Question: Write a single sentence explaining what this figure depicts.
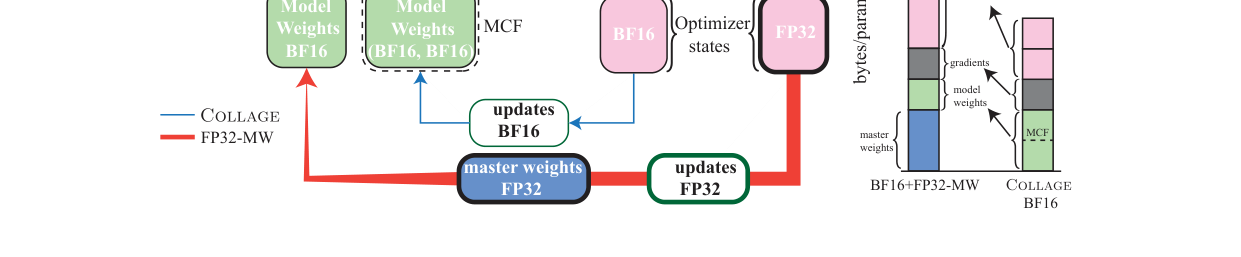
Answer: Left: COLLAGE uses a strict low-precision floating-point (such as BF16) optimization loop without ever needing to upcast to FP32 like in the mixed-precision with master weights (red thick loop). The model weights in COLLAGE are represented as multi- component float (MCF) instead of “standard float”. Right: Total bytes/parameter savings for COLLAGE without taking the FP32 upcasting route. The memory savings and uncompromising use of low-precision results in speed-up as seen in Table 7.